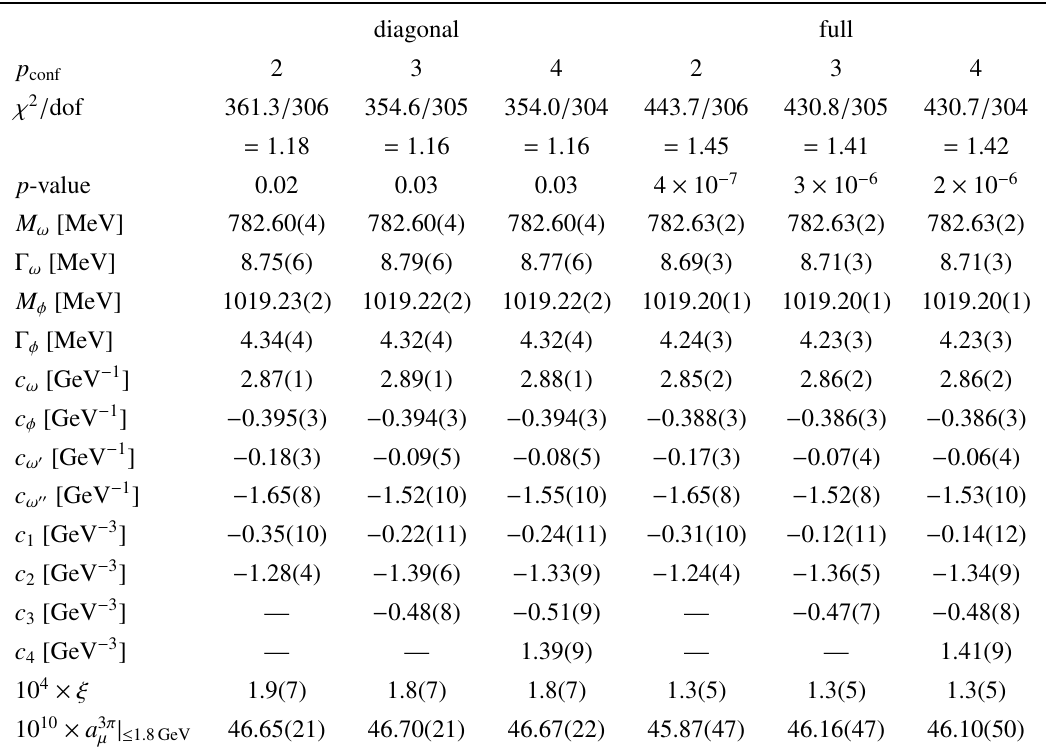
Table 2. Fits to the combined data sets as shown in Table 1, with fit uncertainties given in brackets.